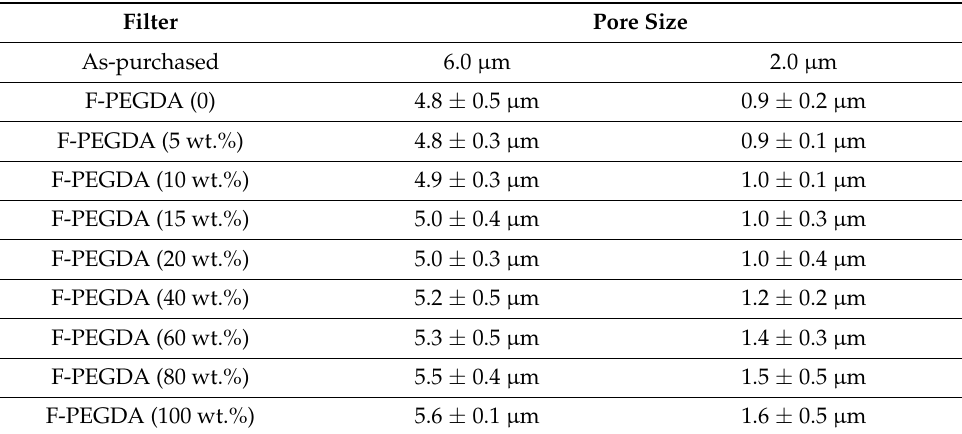
Table 1. Pore size of as-purchased filters and those coated with F-PEGDA with various F-acrylate